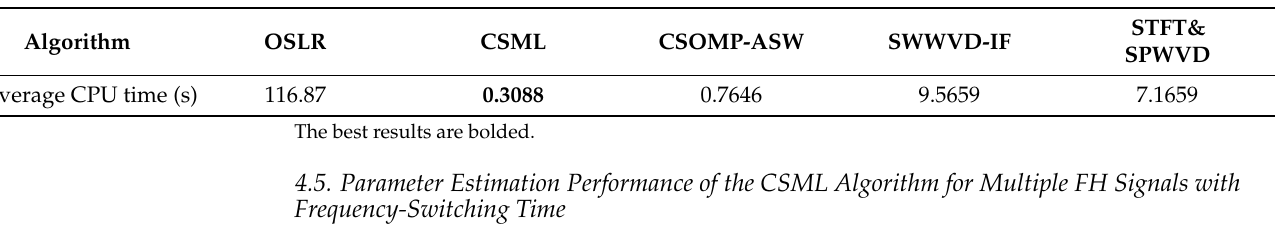
Table 6. Parameters of multiple FH signals with frequency-switching time.